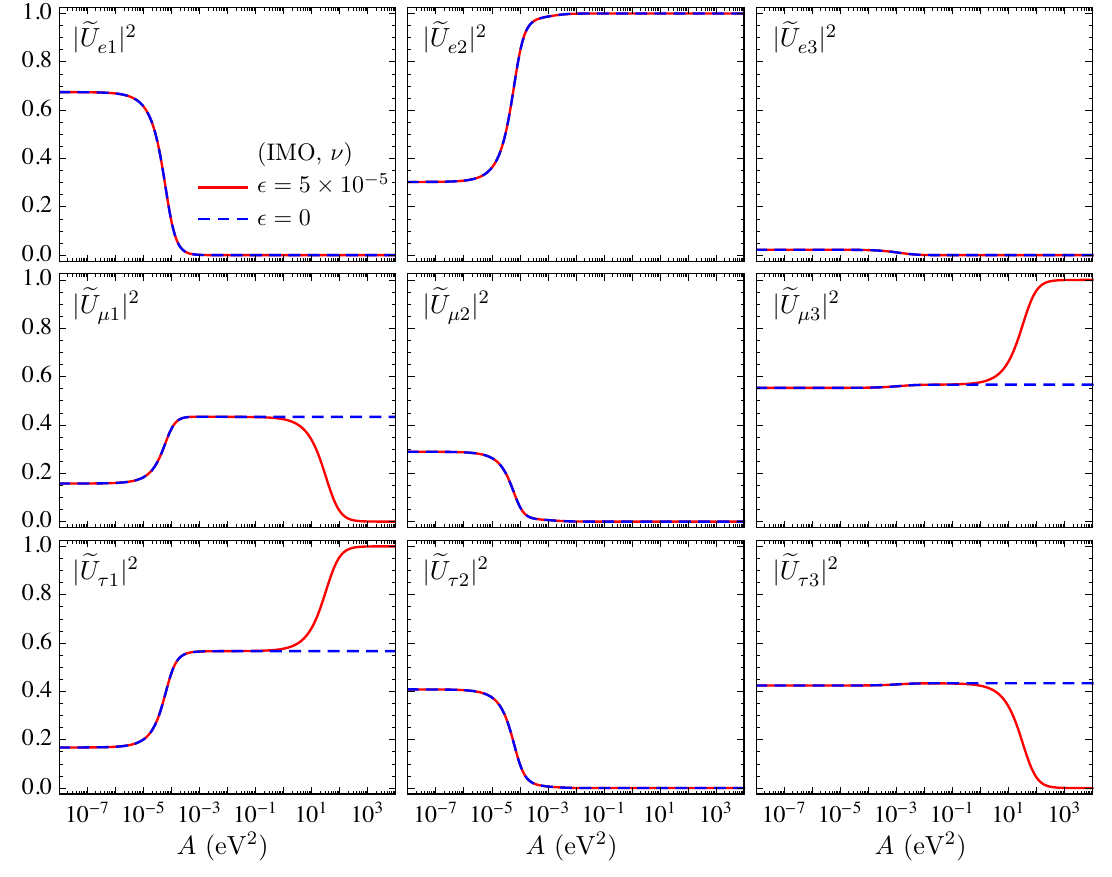
2 (for (cid:11) = U (cid:11)i j j e ; (cid:18) ; (cid:18) ; (cid:14); (cid:1) ; (cid:1) ) in ref. [36, 37] 12 13 23 21 31